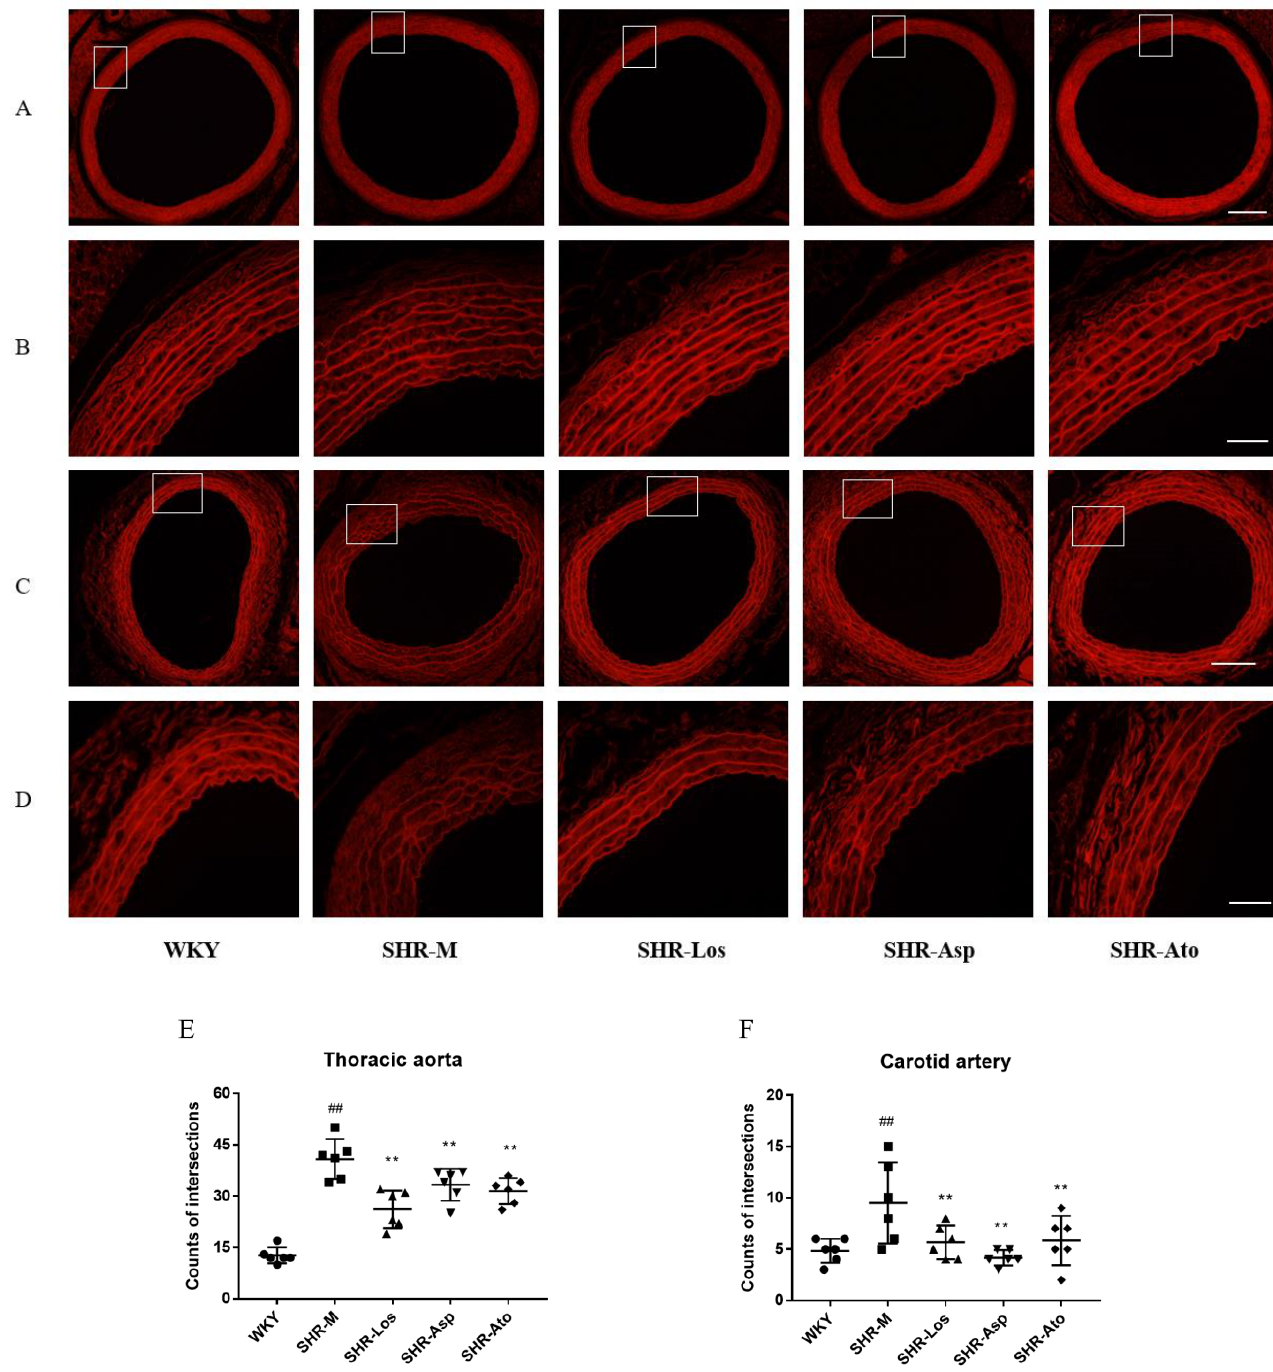
Figure 3. Thoracic aortas ( A,B ) or carotid arteries ( C , D ) elastin by H&E stain under fluorescence microscope showed intense red autofluorescence (22 weeks rats). B and D are enlarged views of A and C, respectively (A: scale bar = 300 μm; B: scale bar = 50 μm; C: scale bar = 200 μm; D: scale bar = 50 μm); ( E ) counts of link across elastin fiber layers in thoracic aortas; ( F ) counts of link across elastin fiber layers in carotid arteries. The data are presented as the mean ± SD. n = 6, ## p < 0.01 vs. WKY; * p < 0.05, ** p < 0.01 vs. SHR-M.